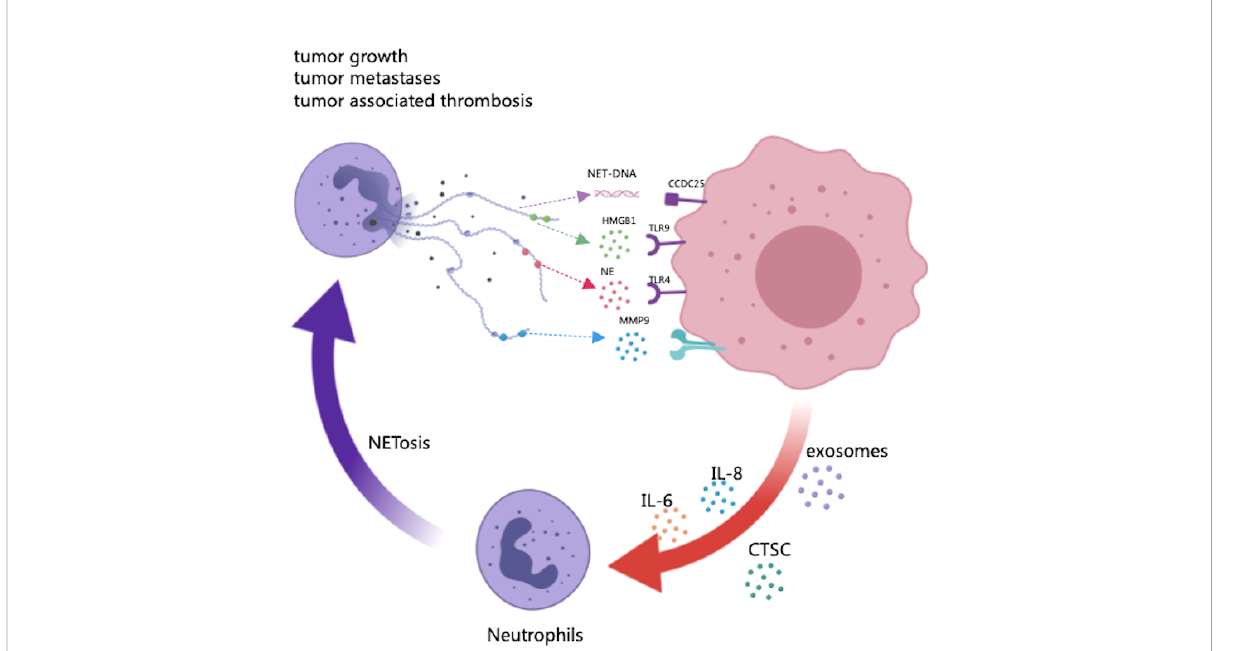
FIGURE 1 The potential role of NETs in tumor progression and metastasis. As scaffolds, NETs capture cancer cells and provide a microenvironment in which protumor genic proteins can be delivered to cancer cells. As part of NETs, HMGB1 is released, activating TLR9-dependent pathways in cancer cells. The NE released by NETs triggers the TLR-4 receptor on cancer cells, resulting in the upregulation of PGC-1, increased mitochondrial biogenesis, and accelerated growth. The transmembrane protein CCDC25 on cancer cells senses extracellular DNA and activates the ILK-parvin pathway to enhance cell motility. In turn, certain factors secreted by many primary tumors have been shown to promote NET formation, such as cytokines (HIF-1, IL-8, IL-6), exosomes and proteases